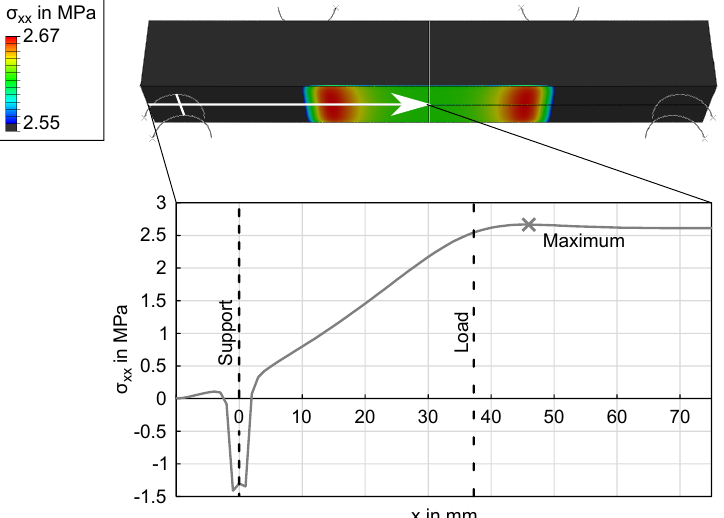
Figure 11. FEM results show the stress in the x -direction of 4PB 75.5 mm with a refined scale (top) and the stress distribution along the lower surface of the bar (bottom).